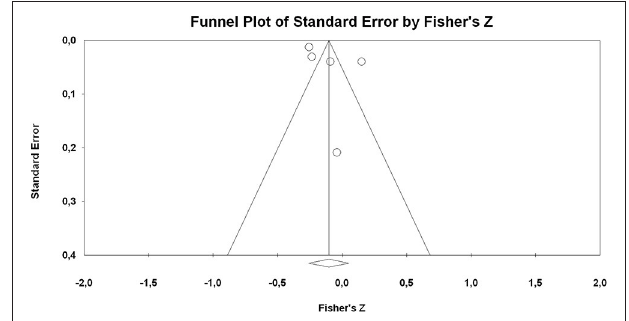
FIGURE 5 | Funnel plots of effect sizes of the correlation between ITI and student’s self-report achievement.